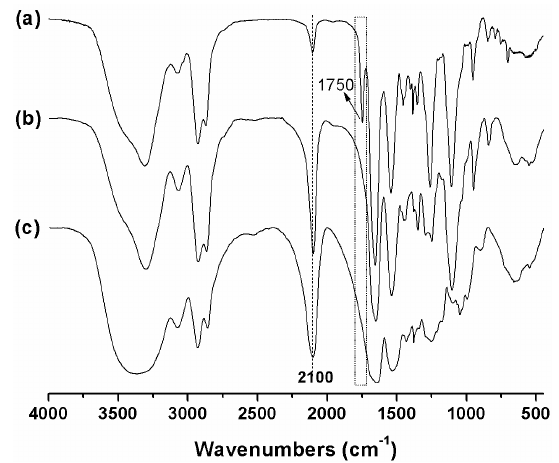
Figure 1. FTIR spectra of ( a ) mPEG ‐ PAAHP ‐ 5, ( b ) mPEG ‐ PAAH and ( c ) PAAH in KBr.